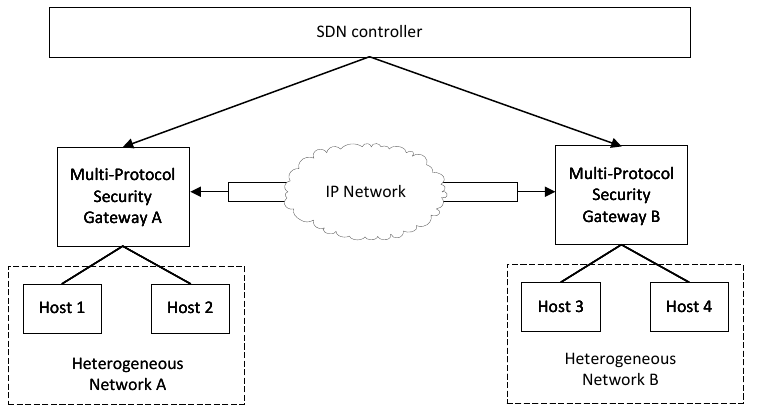
Figure 3. The application scenario of